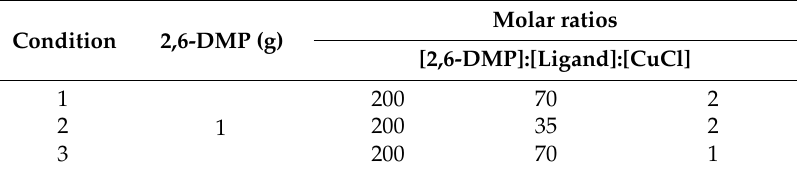
Table 1. Mole ratios of 2,6-DMP, ligand, and CuCl employed in